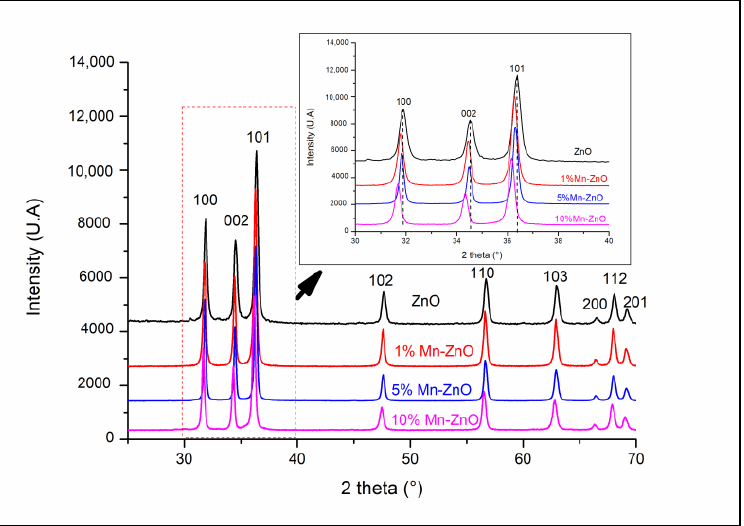
Figure 1. XRD patterns of x%Mn-ZnO nanomaterials.